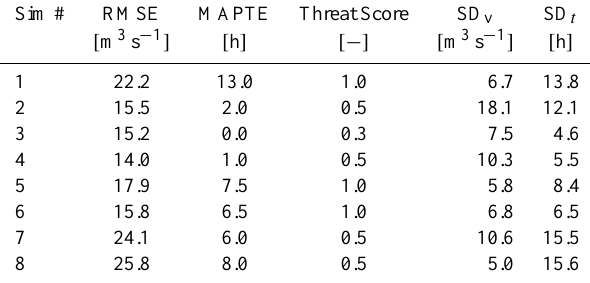
Table 2. Metrics for 8 pairs of simulated and observed hydro- graphs as shown in Fig. 4. RMSE=Root Mean Square Error, MAPTE=Mean Absolute Peak Time Error, SD v =Amplitude Er- ror of Series Distance, SD t =Timing Error of Series